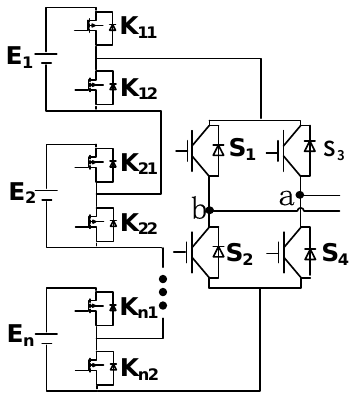
Figure 8. Multilevel DC link inverter.